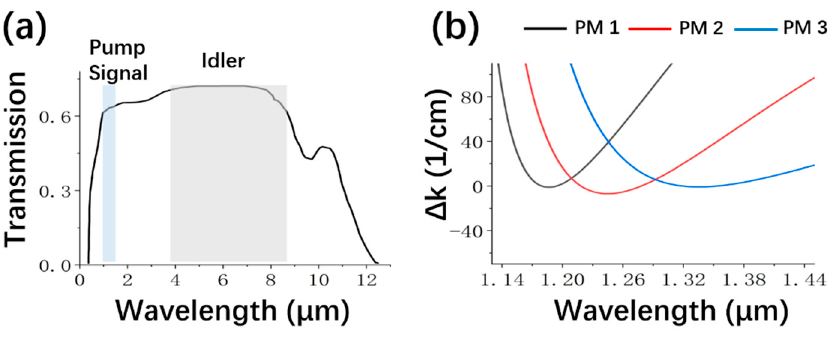
Figure 1. ( a ) The transmission range of LGS crystal, ( b ) three Type-I phase-matching geometries of LGS at XZ plane (PM1, PM2 and PM3 correspond to the phase matching angle 51.2, 45.7, 41.4 degrees and non-collinear angle 0, 1.5, 2.2 degrees respectively).